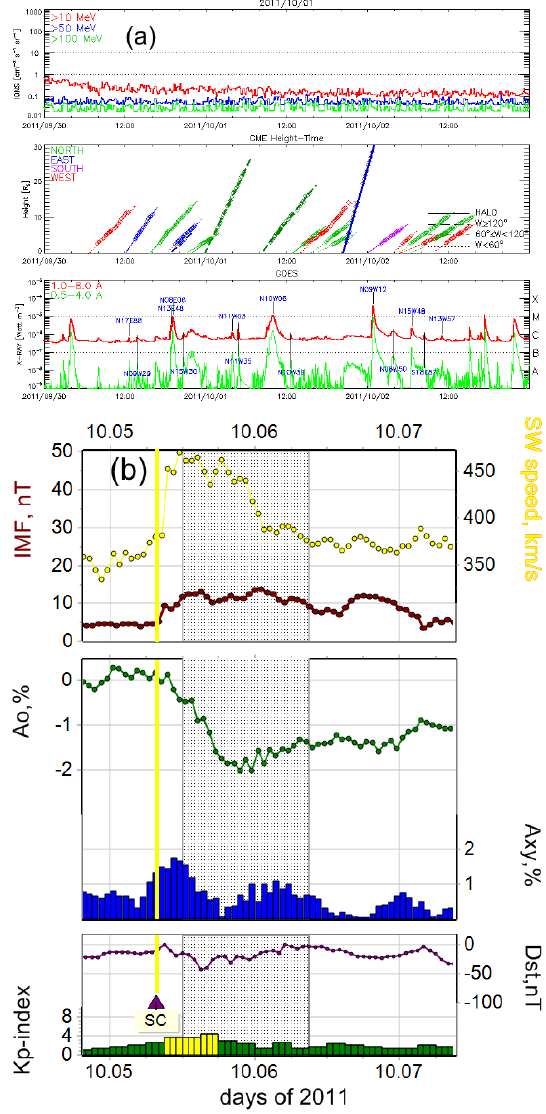
Figure 7. An example of an event from the Control group: ( a ) PHTX (taken from SOHO/LASCO CME Catalog); ( b ) behavior of the main SW, IMF, CR, and GA parameters during the FD on 5–7 October